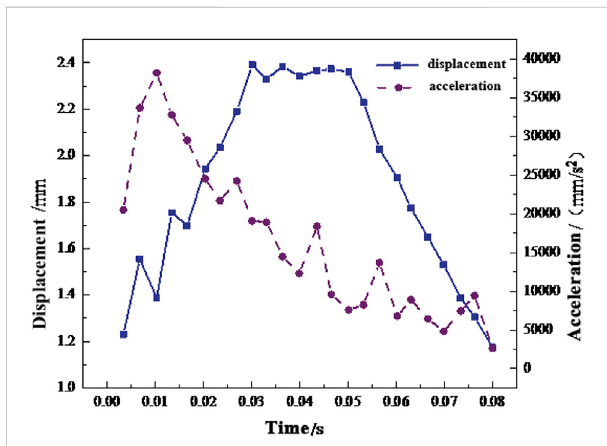
FIGURE 6 Displacement and acceleration change curves of each load step of the top beam.